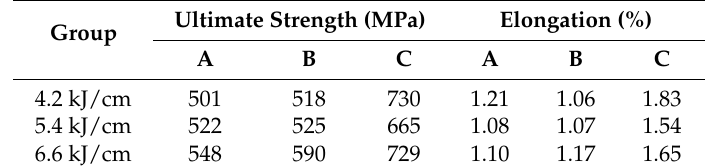
Table 4. Mechanical properties of samples from the tensile tests.